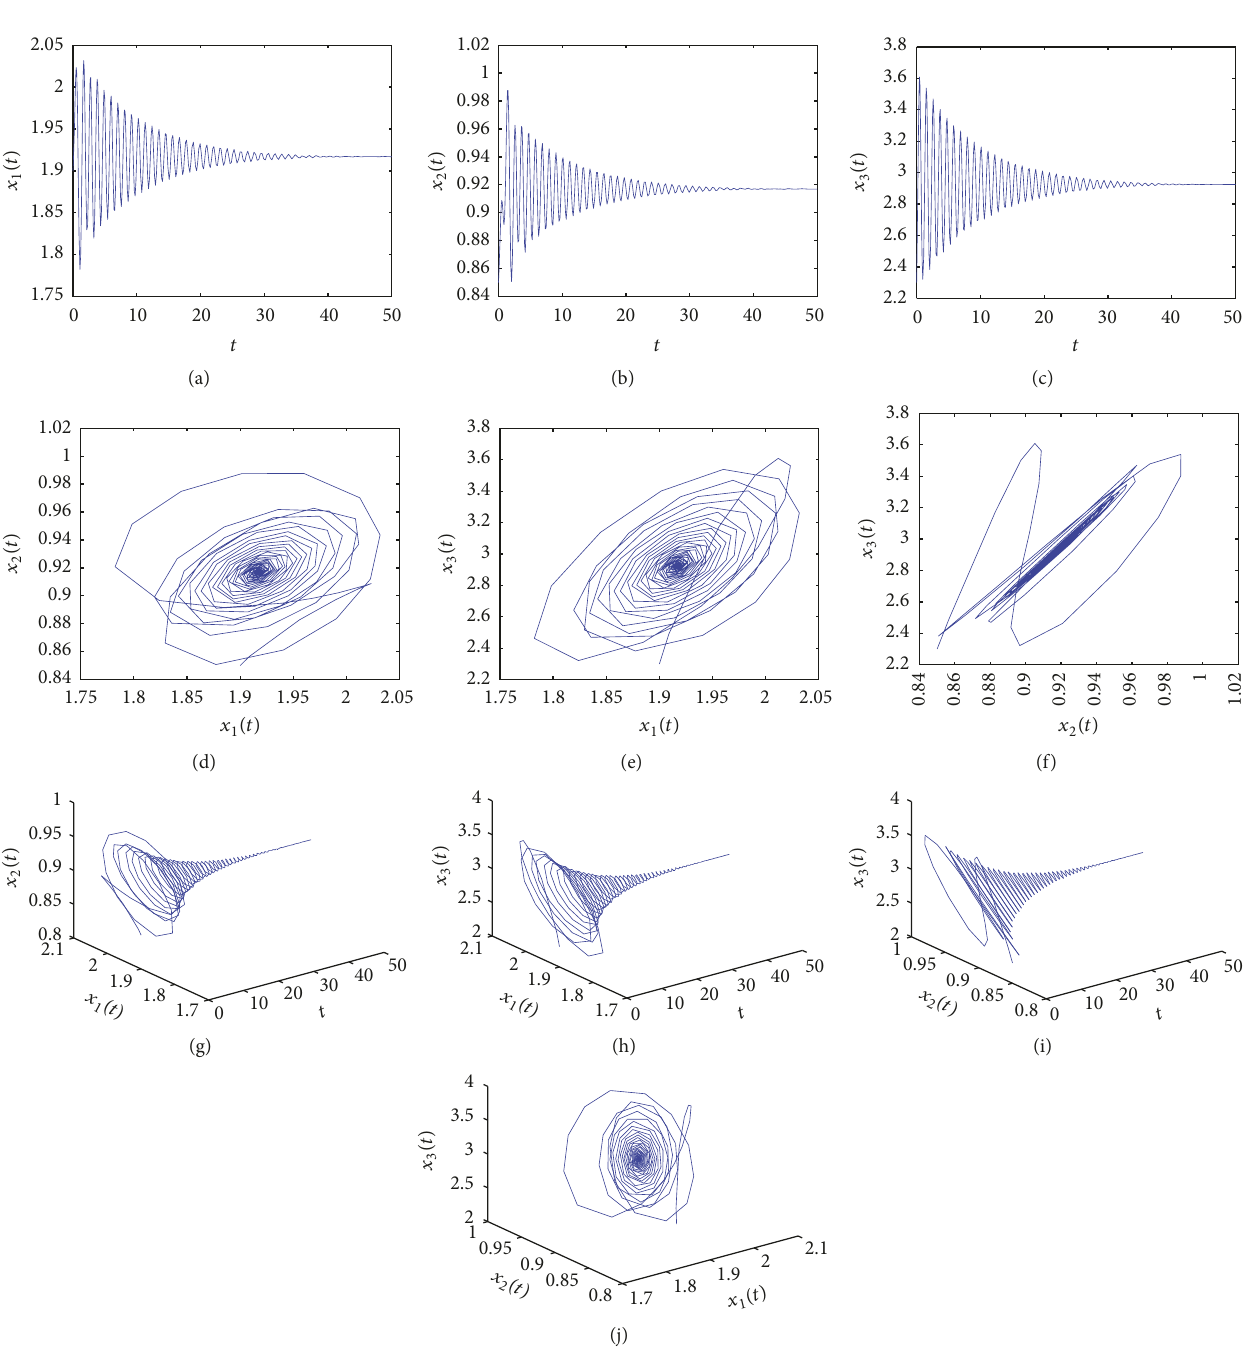
Figure 1: Dynamical behavior of system (81) with 𝜏 = 0.26 < 𝜏 0 ≈ 0.265 . The positive equilibrium 𝐸 0 (1.9170, 0.9170, 2.9251) is asymptotically stable. The initial value (𝑥 1 (0), 𝑥 2 (0),𝑥 3 (0)) = (1.9, 0.85, 2.3)